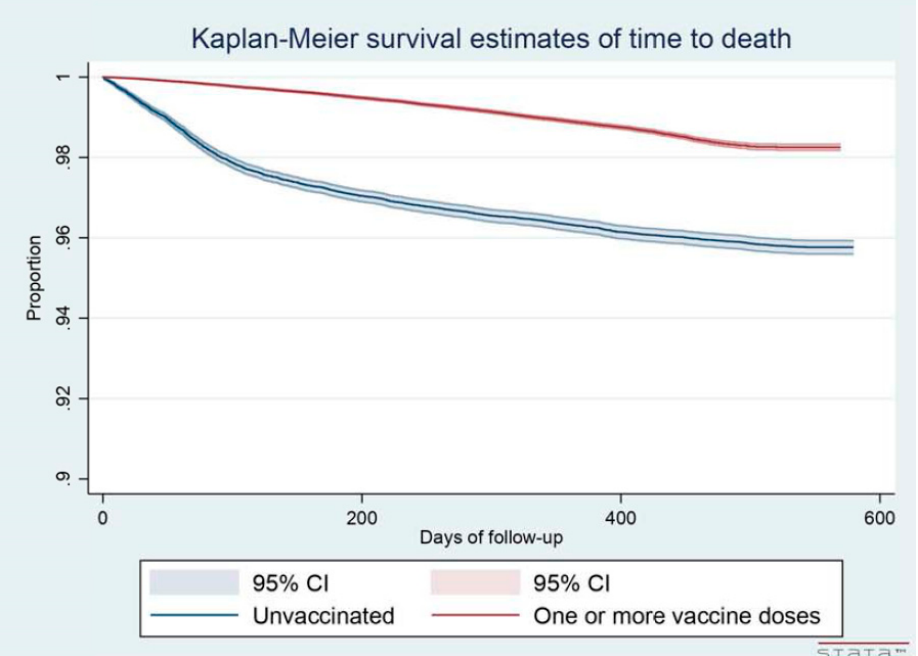
Figure 2. Kaplan-Meier estimates of time to death by vaccination status (at least one dose of COVID-19 vaccines vs. unvaccinated).